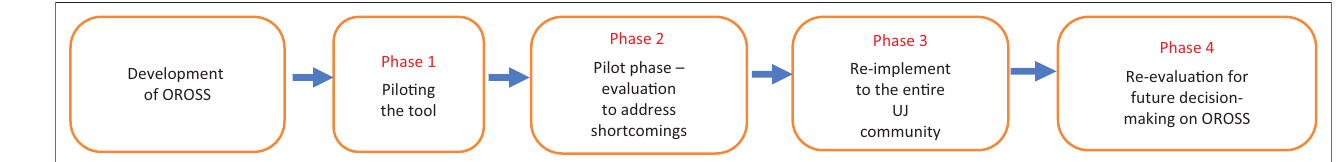
FIGURE 1: Online Research Output Submission System work flow.